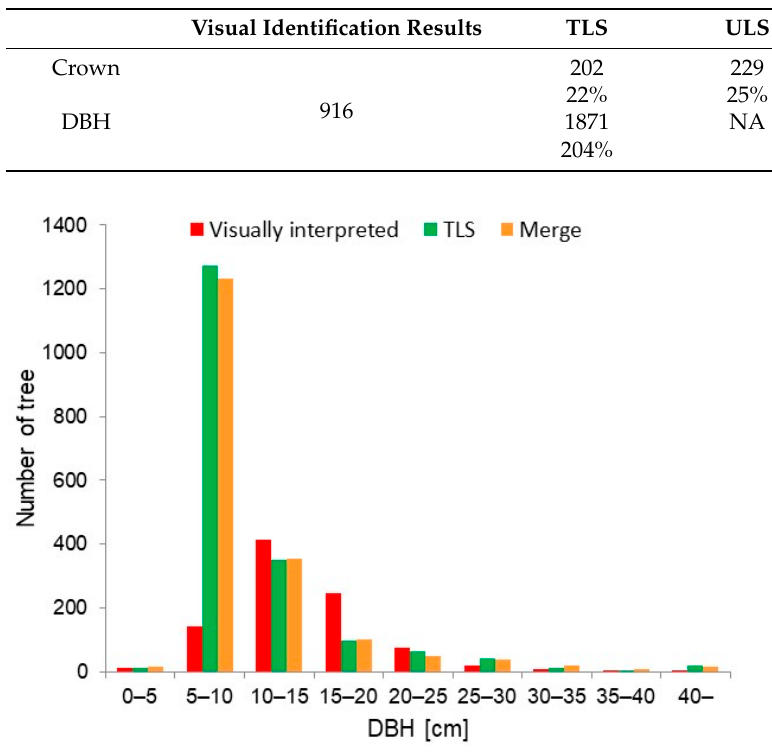
Figure 6. DBH distribution of trees identified through tree